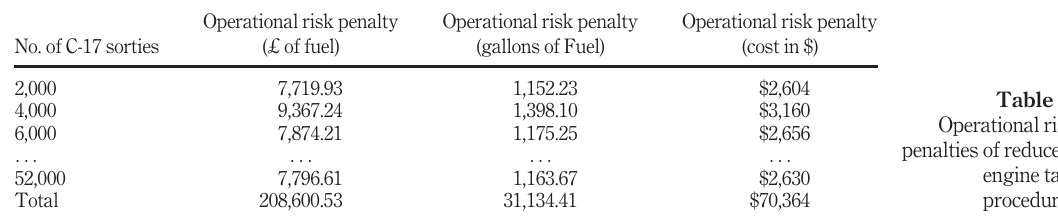
Table 5. Operational